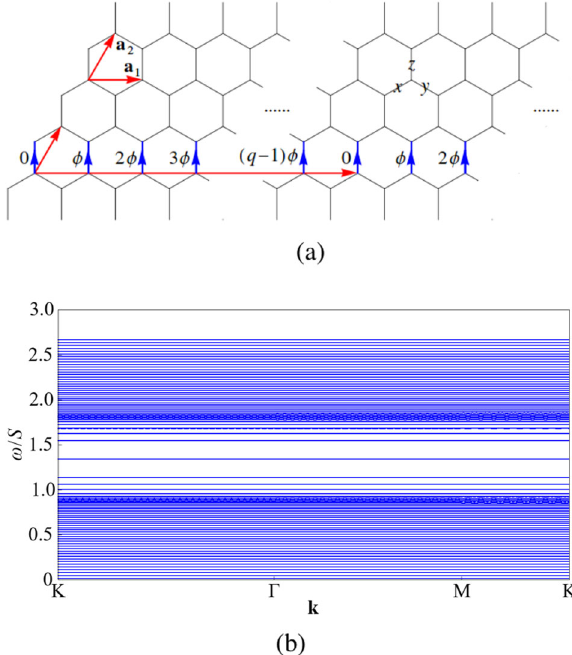
Fig. 3 Bosonic Hofstadter problem. a Optimal gauge in which the magnons only gain an additional U (1) phase of n 1 ϕ when hopping along the z bonds, as indicated by the blue arrows. Such a gauge choice breaks the translational symmetry of the original lattice (with the primitive vectors a 1 and a 2 ). The resulting magnetic unit cell contains 2 q sublattices for a fl ux of ϕ = − 2 π p / q per unit hexagon, where p and q are relatively prime. b Magnon dispersion along high- symmetry directions in the fi rst Brillouin zone, for the vortex liquid at φ ¼ tan (cid:2) 1 ð 1 = 2 Þ and h / S = 1.3. Since the fl ux per unit hexagon is ϕ = − 2 π × 1/50, there are in total 2 × 50 = 100 bands. The bands are nearly fl at. Dispersive features are only visible in few bands at intermediate